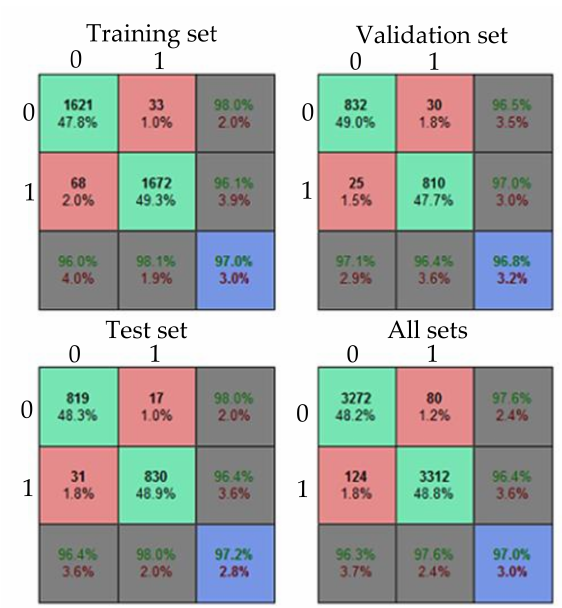
Figure 12. Training results of the 3–3-layer network model.